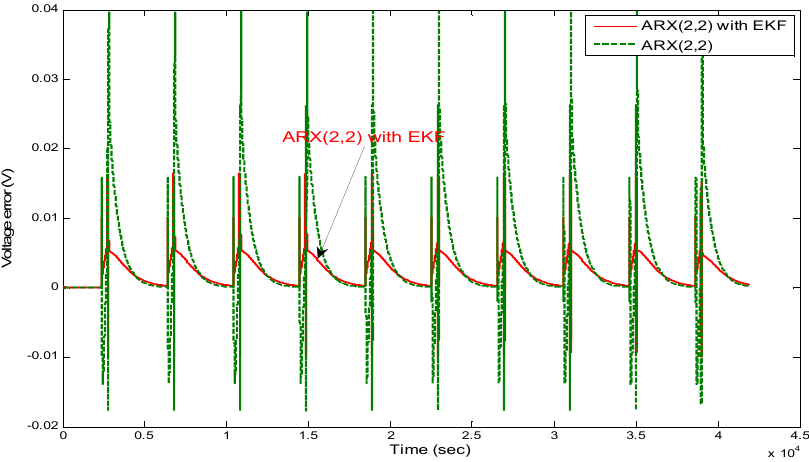
Figure 21. Model voltage errors between two different models.